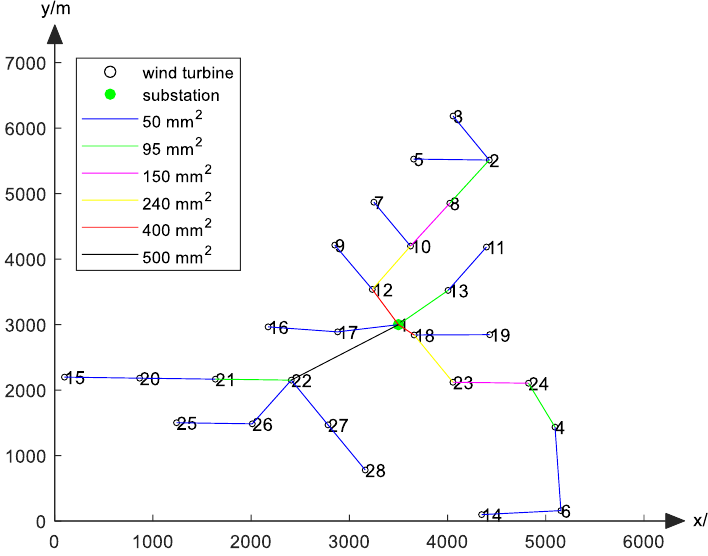
Figure 11. The topology of cables’ connection (given substation location).